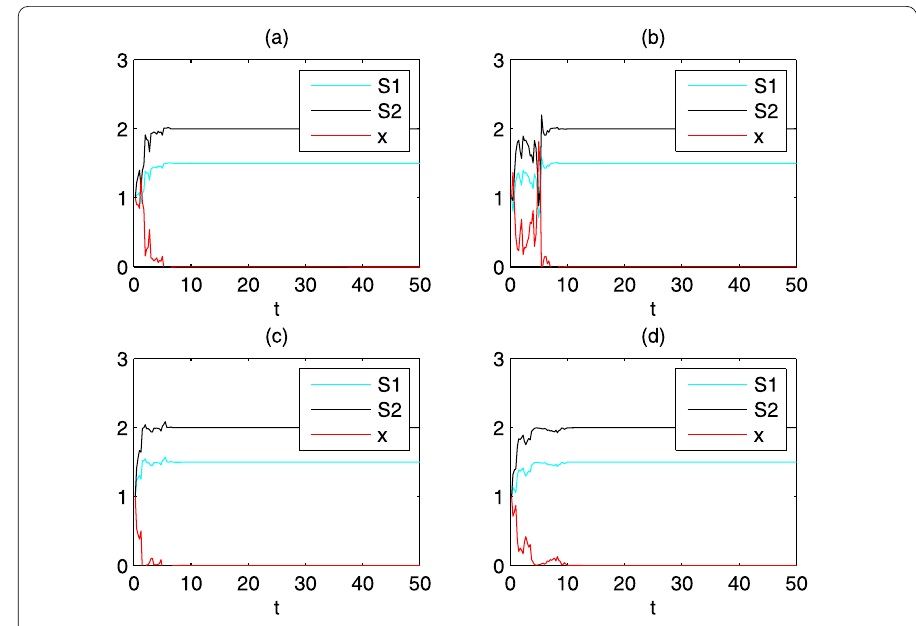
Figure 2 Time evolutions of the stochastic system with parameters S 10 = 1.5, S 20 = 2, Q = 1.45, δ 1 = 0.9, δ 2 = 1, a 1 = 1.6, a 2 = 1.6, μ 1 = 0.8, μ 2 = 0.8, r = 0.1, k = 1, g = 0.8, h = 1, m = 0.2, u = 0.1, T = 1. ( a ) Time series for S 1 ( t ), S 2 ( t ), x ( t ) with parameters σ 1 = 0.6, σ 2 = 0.9, R ∗ 1 = 0.6759. ( b ) Time series for S 1 ( t ), S 2 ( t ), x ( t ) with parameters σ 1 = 1, σ 2 = 0.7, R ∗ 2 = 0.6419. ( c ) Time series for S 1 ( t ), S 2 ( t ), x ( t ) with parameters σ 1 = 1.5, σ 2 = 1.6, R ∗ σ 1 = 0.5, σ 2 = 0.5, R ∗ 3 = 0.1830. ( d ) Time series for S 1 ( t ), S 2 ( t ), x ( t ) with parameters 4 = 0.9896